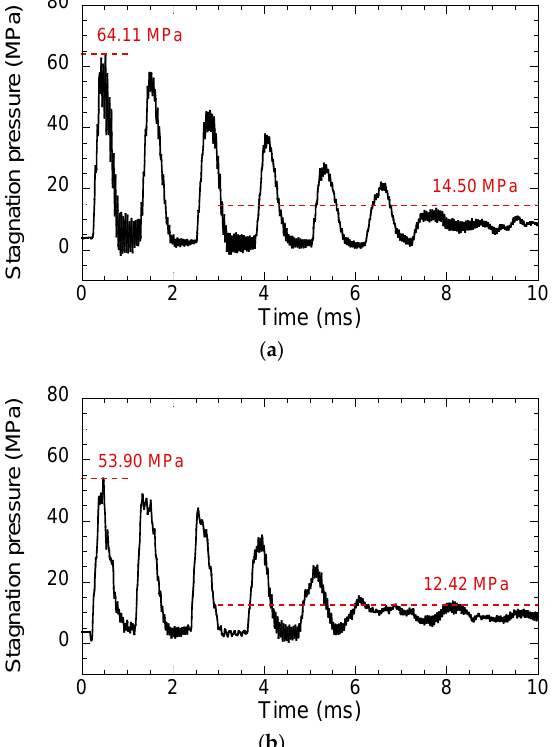
Figure 9. Injection of a solution with 30% (by weight) glycerol using the present detonation-driven injector device with ( a ) 40kPa and ( b ) 45 kPa initial combustible pressure.